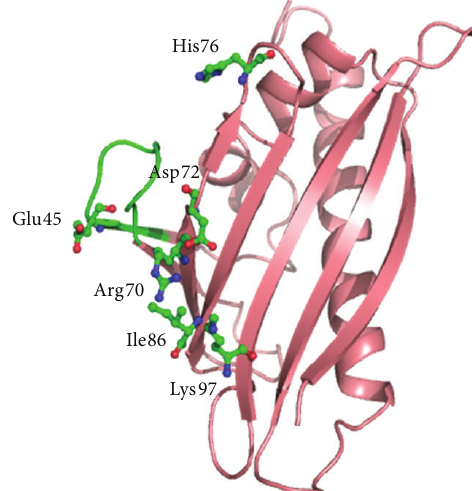
Figure 12: Overall structure of Bet v 1 protein showing the conformational epitope formed by amino acid residues from Glu42 to Thr52 (in green) and additional dispersed amino acids Arg70, Asp72, His76, Ile86, and Lys97 (in green) for Fab binding. The critical residue for antibody binding Glu45 is